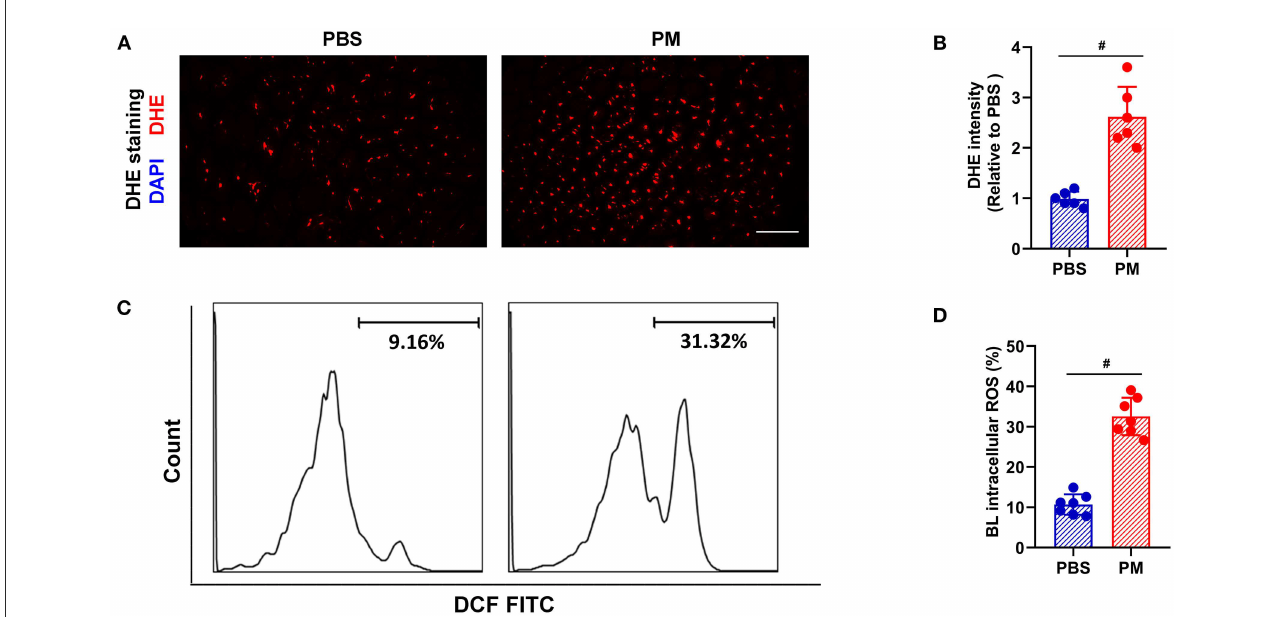
FIGURE2 PM treatment increased the levels of ROS in blood and ischemic limb in mice. ROS levels in the ischemic limbs were evaluated using DHE staining, while ROS levels in circulating mononuclear cells were assessed using flow cytometry. As shown in (A–D) , the ROS levels in the ischemic tissue and circulating mononuclear cells were significantly increased in PM-treated mice over the controls ( # p < 0.01). DAPI, 4 ′ , 6-diamidino-2-phenylindole; DHE, dihydroethidium; BL, blood; Scale bar, 50 µ m. n = 6/group. Statistical differences were determined with Student’s two-tailed t